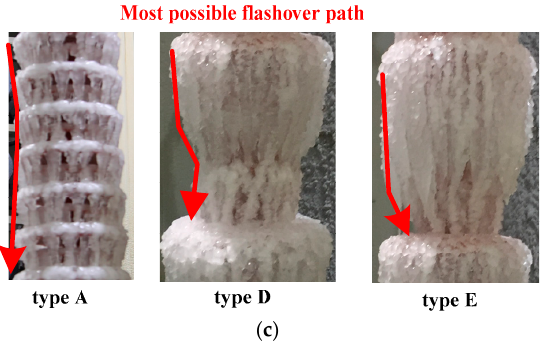
Figure 8. Most possible flashover path under different icing conditions. ( a ) d = 5 mm; ( b ) d = 15 mm; and ( c ) d = 25 mm.